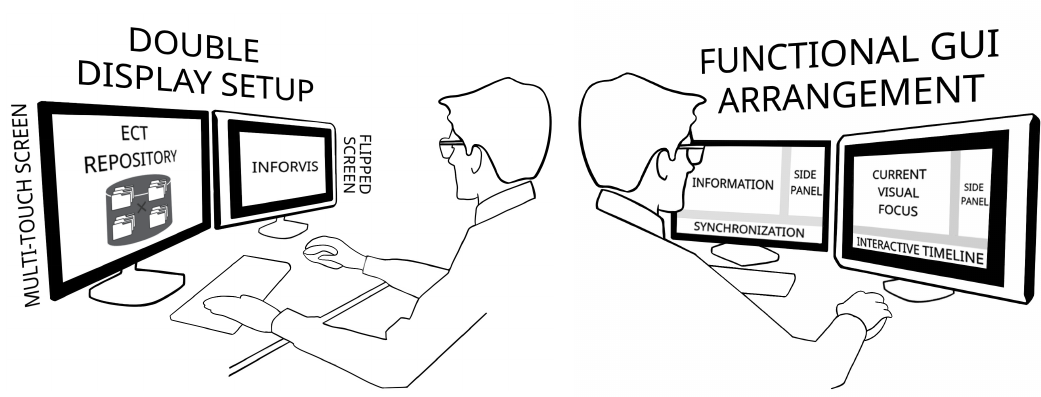
Figure 5. INFORVIS system functional prototype sketches. Left picture shows the double display set-up with a multi-touch interface capacity and a flipped screen deployed for ECT data analysis. Right picture presents functional GUI arrangement with the ITL timeline and information visuals screen